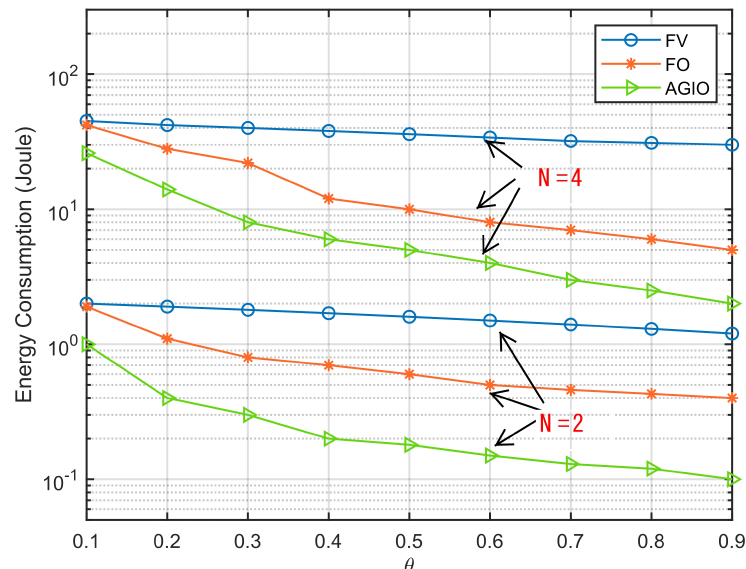
Figure 5. Comparison of energy consumption with different θ .